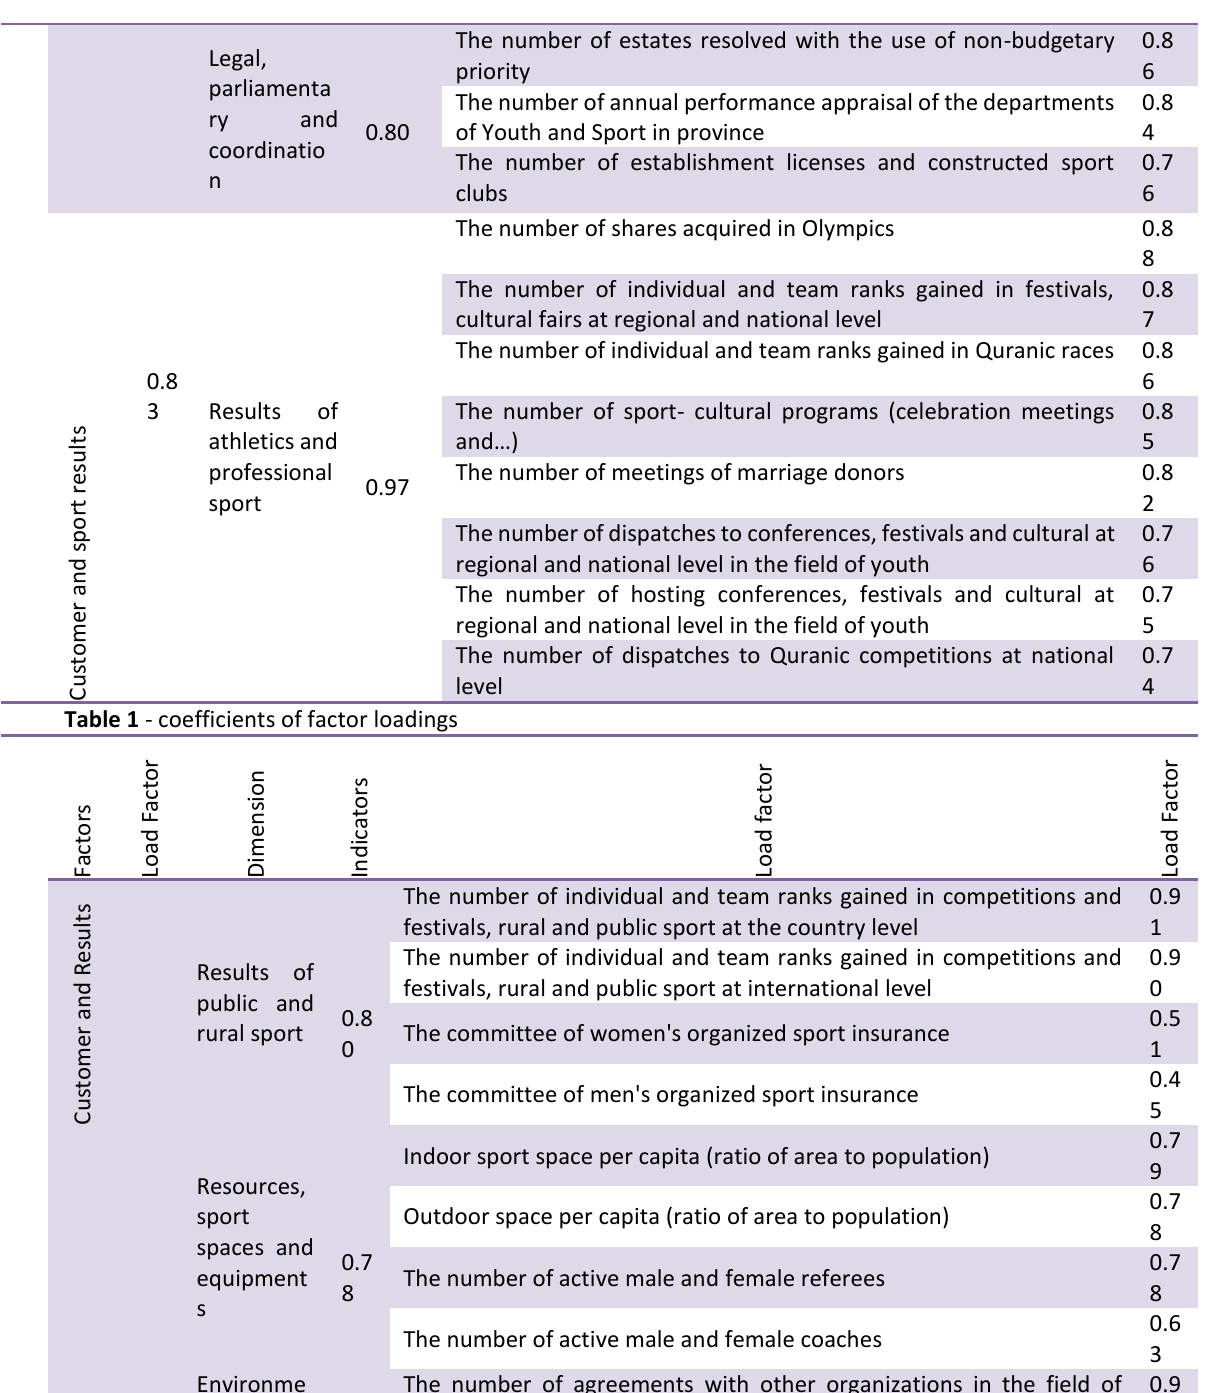
Table 1 - coefficients of factor